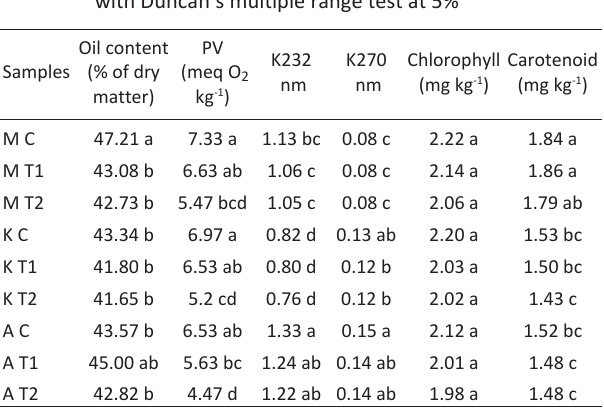
M= Mission; K= Koroneiki; A= Arbequina; C= control sample; T1= 1 week freezing sample; T2= 3 week freezing sample; PV= peroxide value. Means within a column with the same lowercase letters are not significantly different.